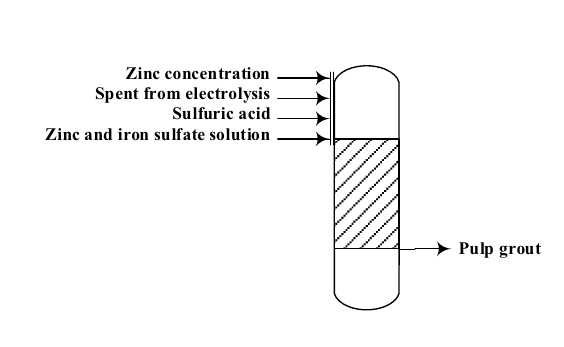
Fig. 2 Inputs and outputs of pulp